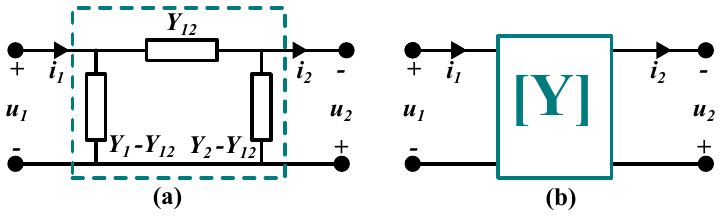
Figure 1. Network representation of CPT: ( a ) A π model. ( b ) A linear two-port